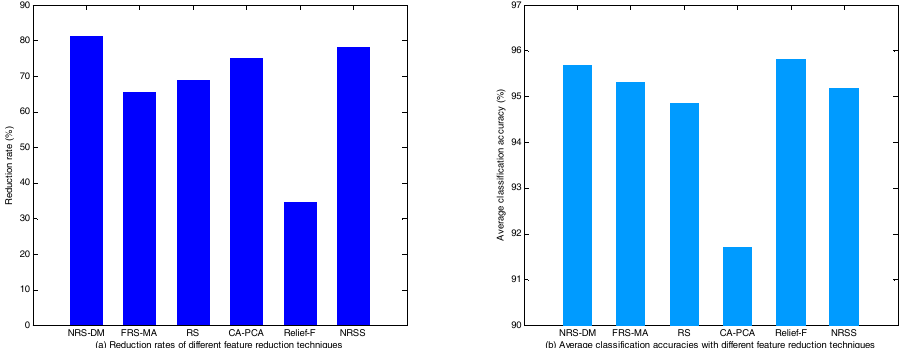
Figure 7. Performance comparison in the condition of N -1 contingencies (NES39). Table 4. Results in the condition of N -1 contingencies (NES39).